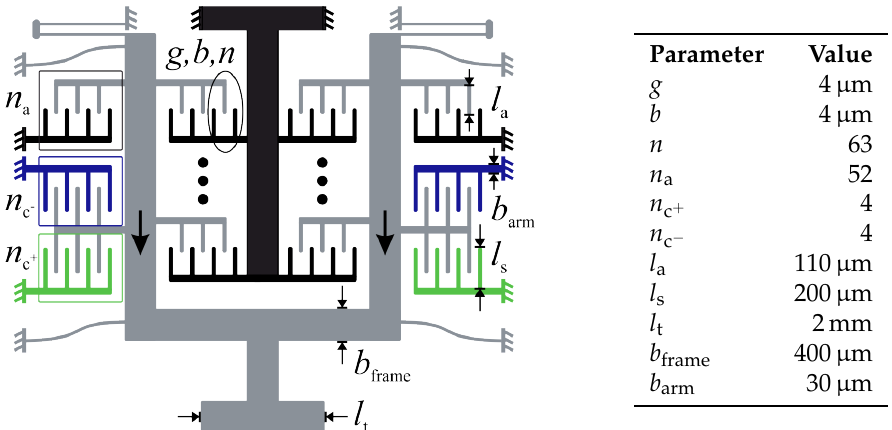
Figure 4. Schematic view of the constant-force actuator design that includes fixed combs for the electrostatic actuation and voltage supply (black), moveable combs on a frame with the free standing measurement tip that are suspended by the non-linear spring system on the four corners (grey) and the fixed combs for differential capacitance measurement (blue and green). The parameters g , b , and n are described in Section 2.1.